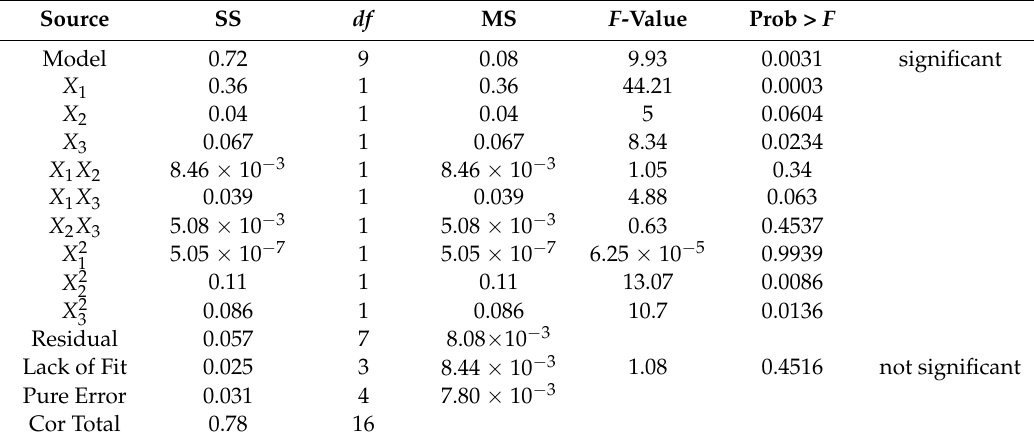
Table 5. ANOVA results of quadratic model for DHA production ( R 2 = 0.9210; Pred R 2 = 0.7290; Adj R 2 = 0.8559; CV% =